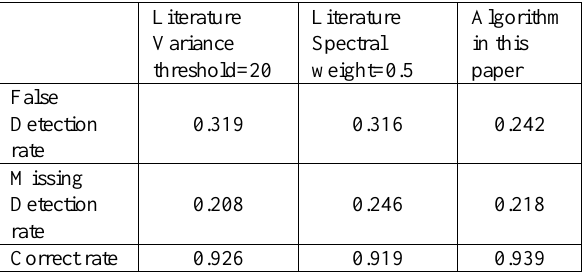
Table 2. Change detection accuracy comparison of the for